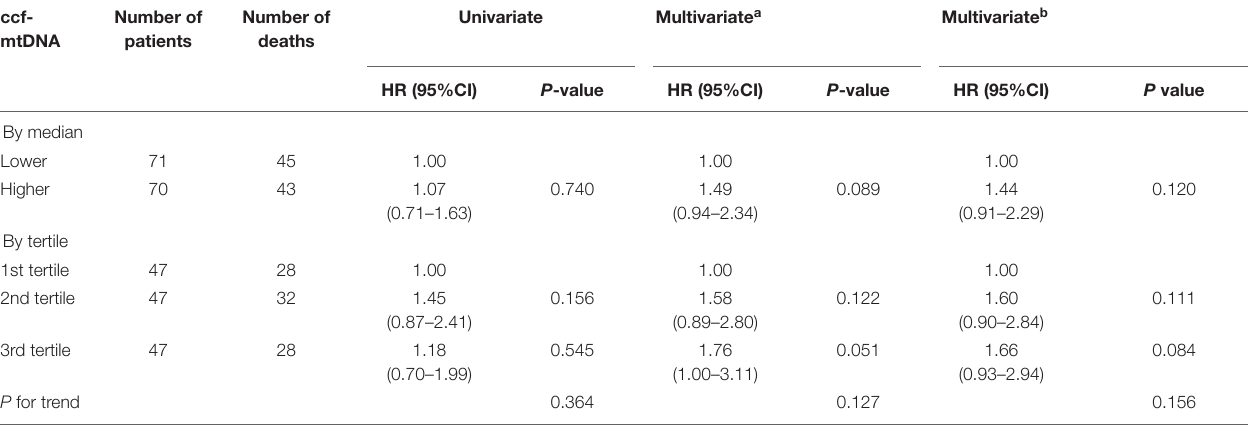
Univariate Multivariate a